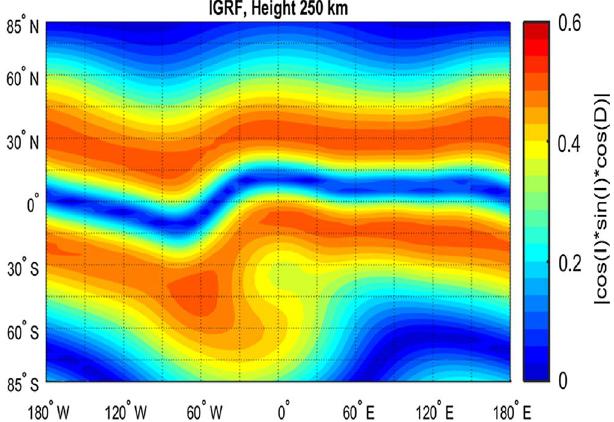
Fig. 15. Effectiveness of vertical plasma transport due to meridional thermospheric winds at 250 km